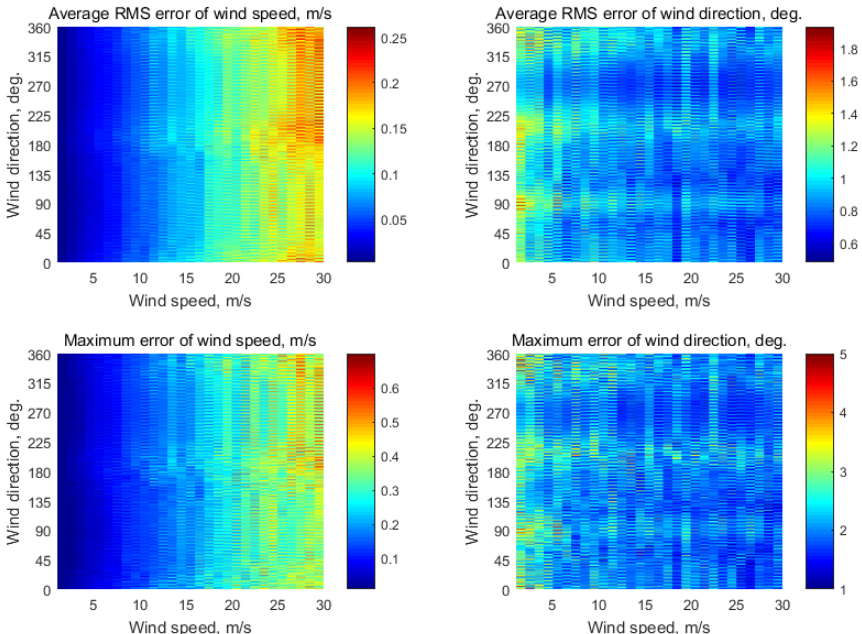
Figure A4. Semicircular wind retrieval results at a single 40° incidence angle.